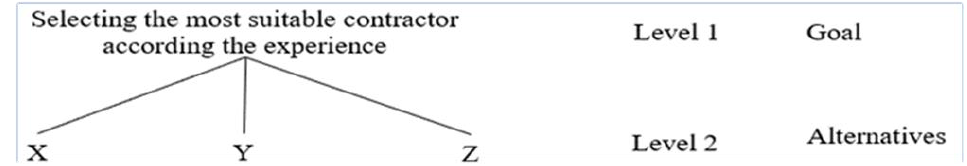
Figure 1. Flowchart of the Analysis Process.